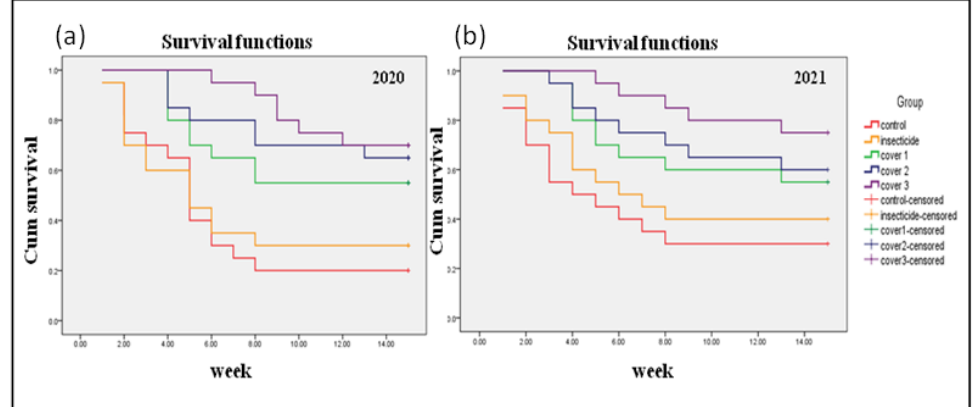
Figure 5. Survival curves (Kaplan–Meier) drawn from the leaf curl observation (under different cover) in the susceptible chilli genotype (HPH-1041) at IARI experimental field in New Delhi during 2020 ( a ) and 2021 ( b ) seasons. Table 1. Cox models for different periods of plant cover (interception) in relation to leaf curl infection in susceptible chilli genotype (HPH-1041) observed at IARI experimental field, New Delhi, in 2020 and